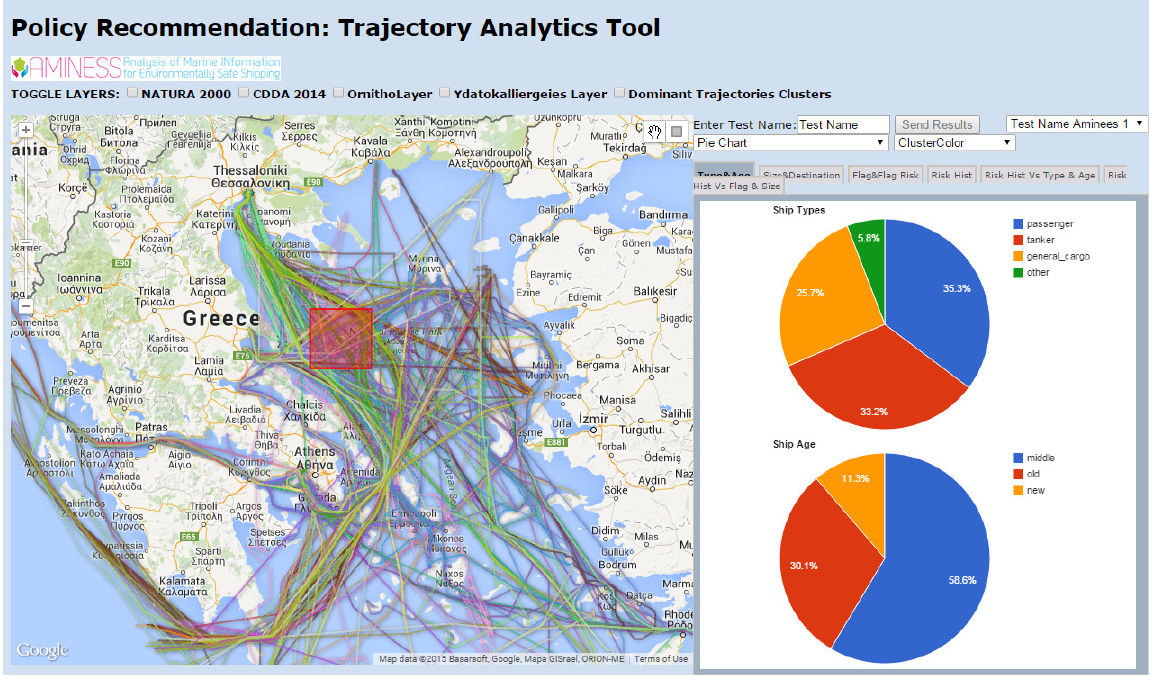
Figure 1: Screenshot of the long-term monitoring